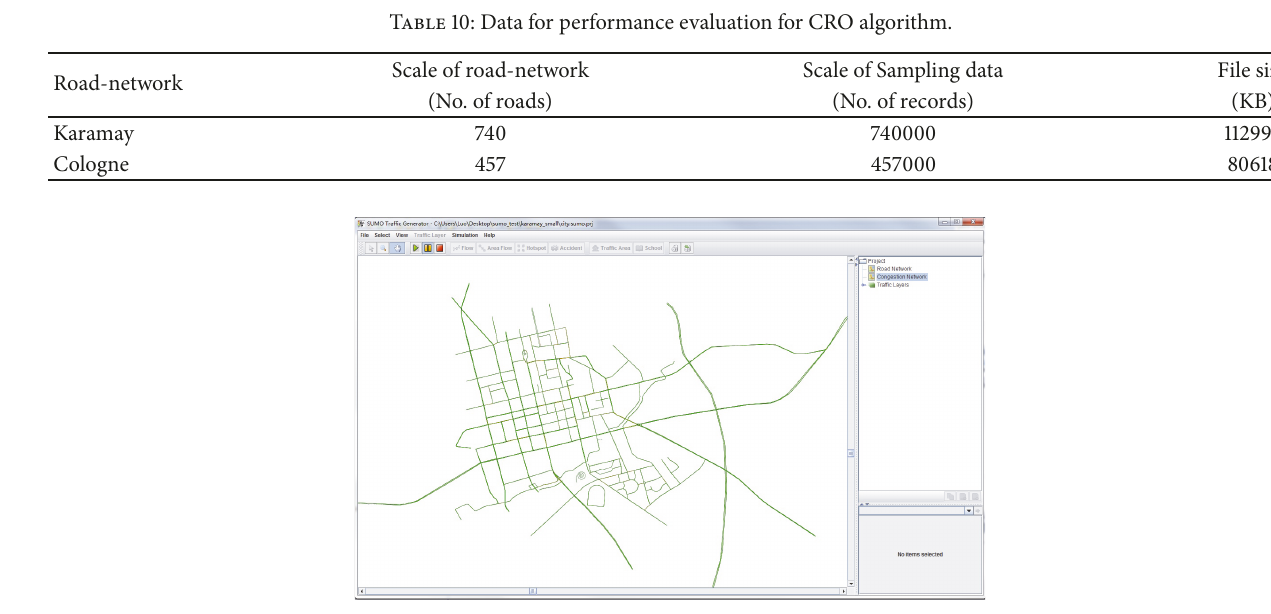
Figure 6: Whole road network of